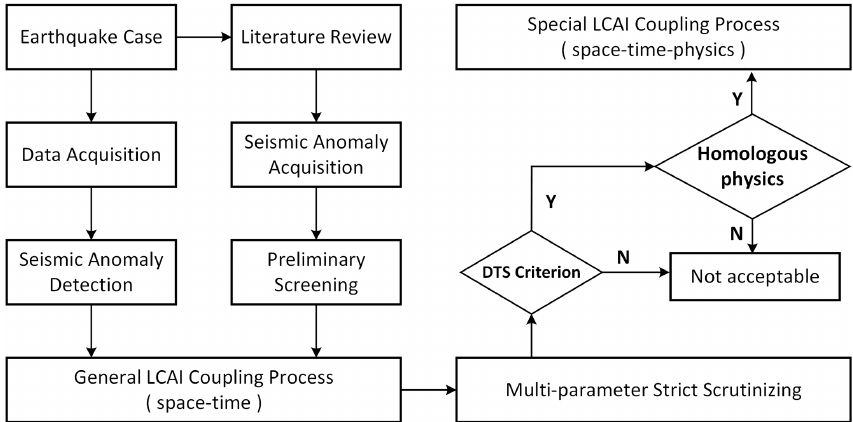
Figure 2. The technical route of scrutinizing and rooting multiple seismic anomalies using the DTS criterion and homologous physics.